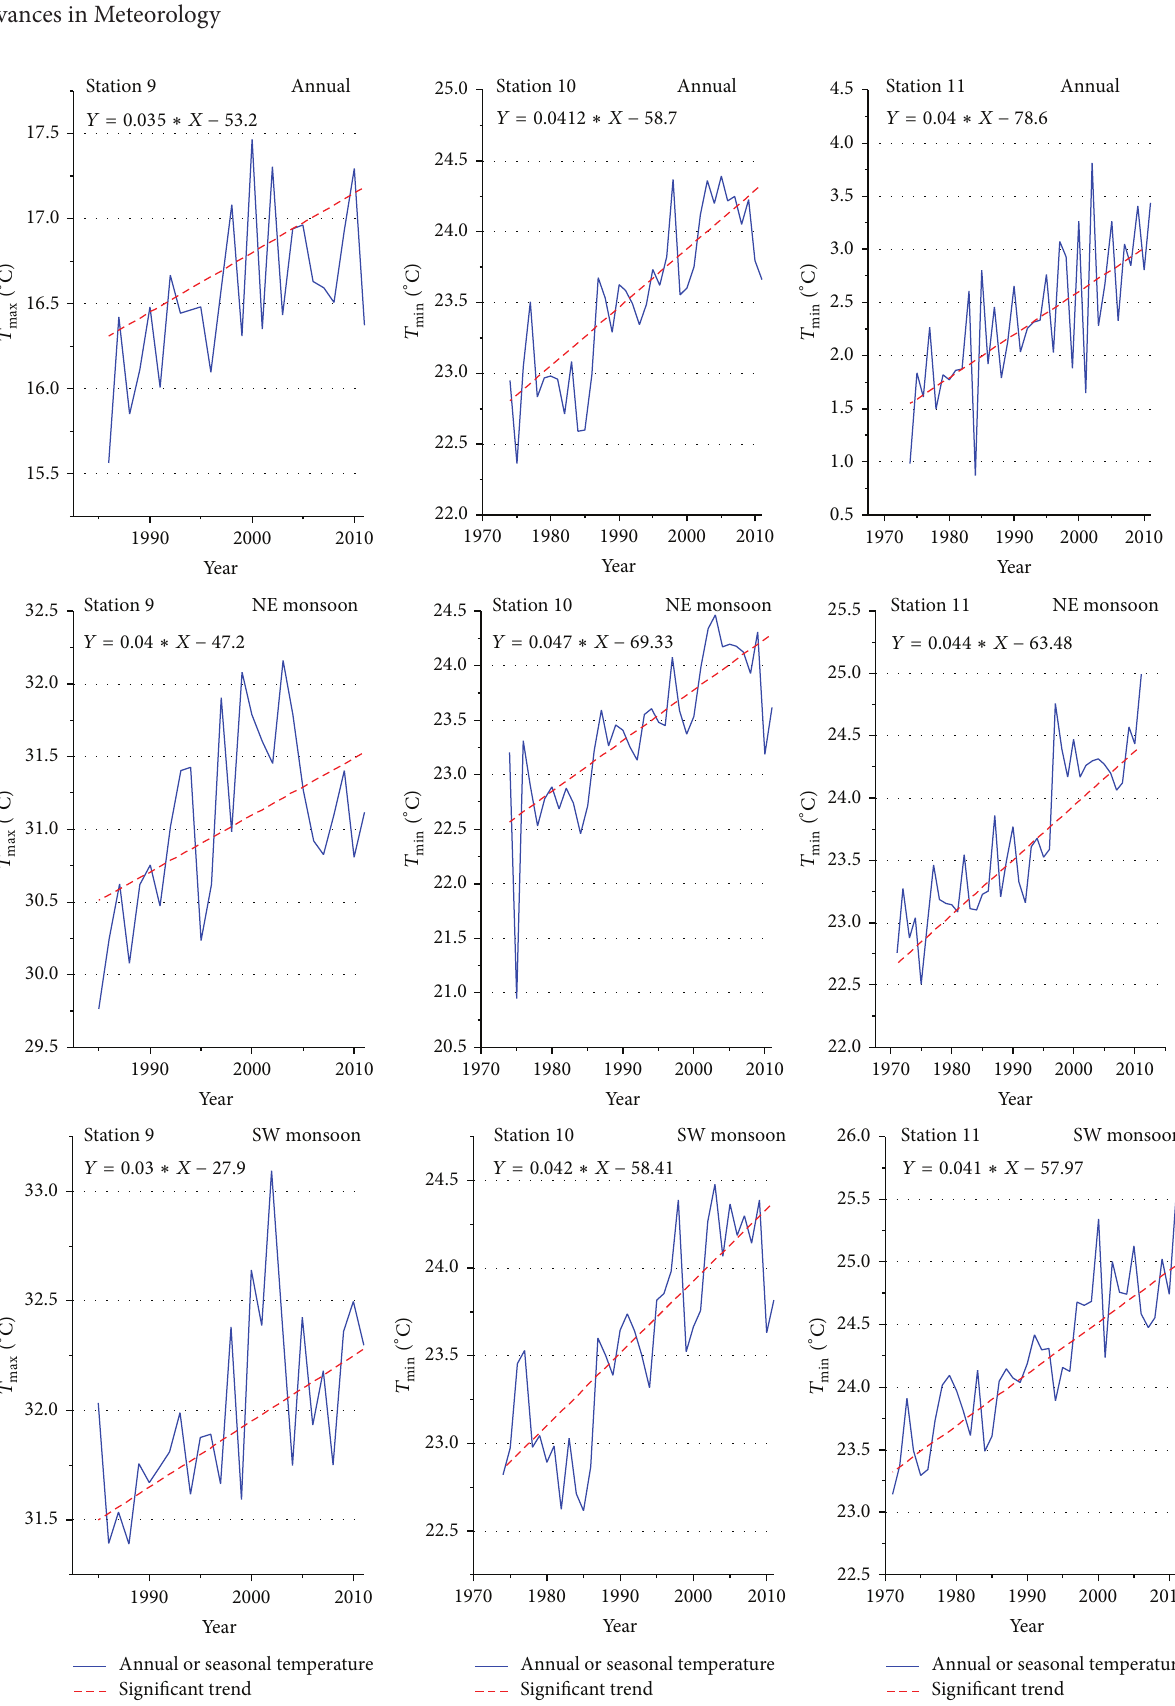
Figure 6: Results of significant MK trends for annual and seasonal temperature variables in the Langat River Basin at the 95% confidence